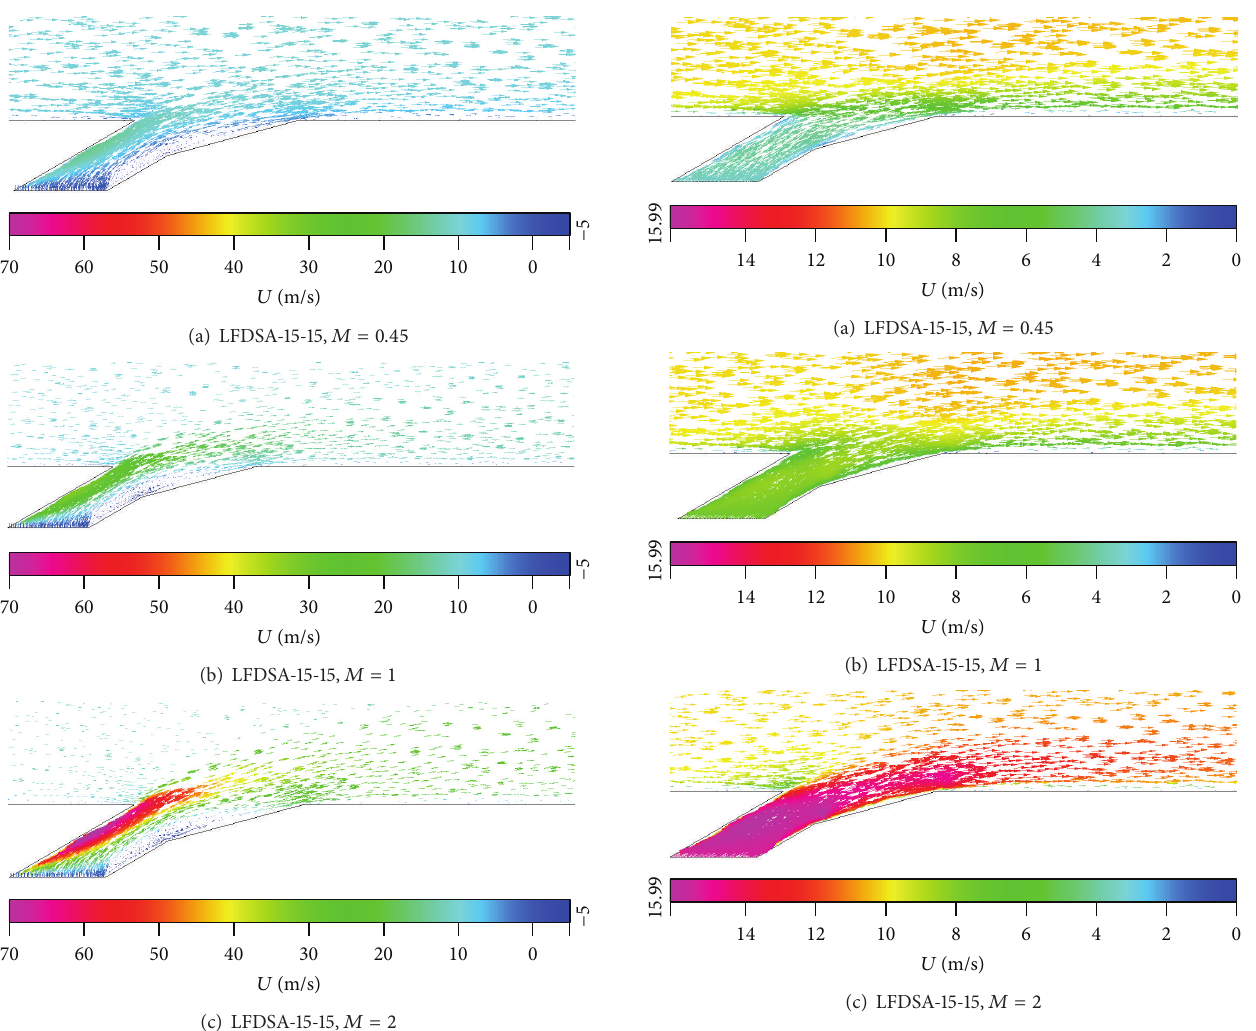
Figure 19: Velocity vectors on a symmetric plane and the coolant velocity normal to boundary.